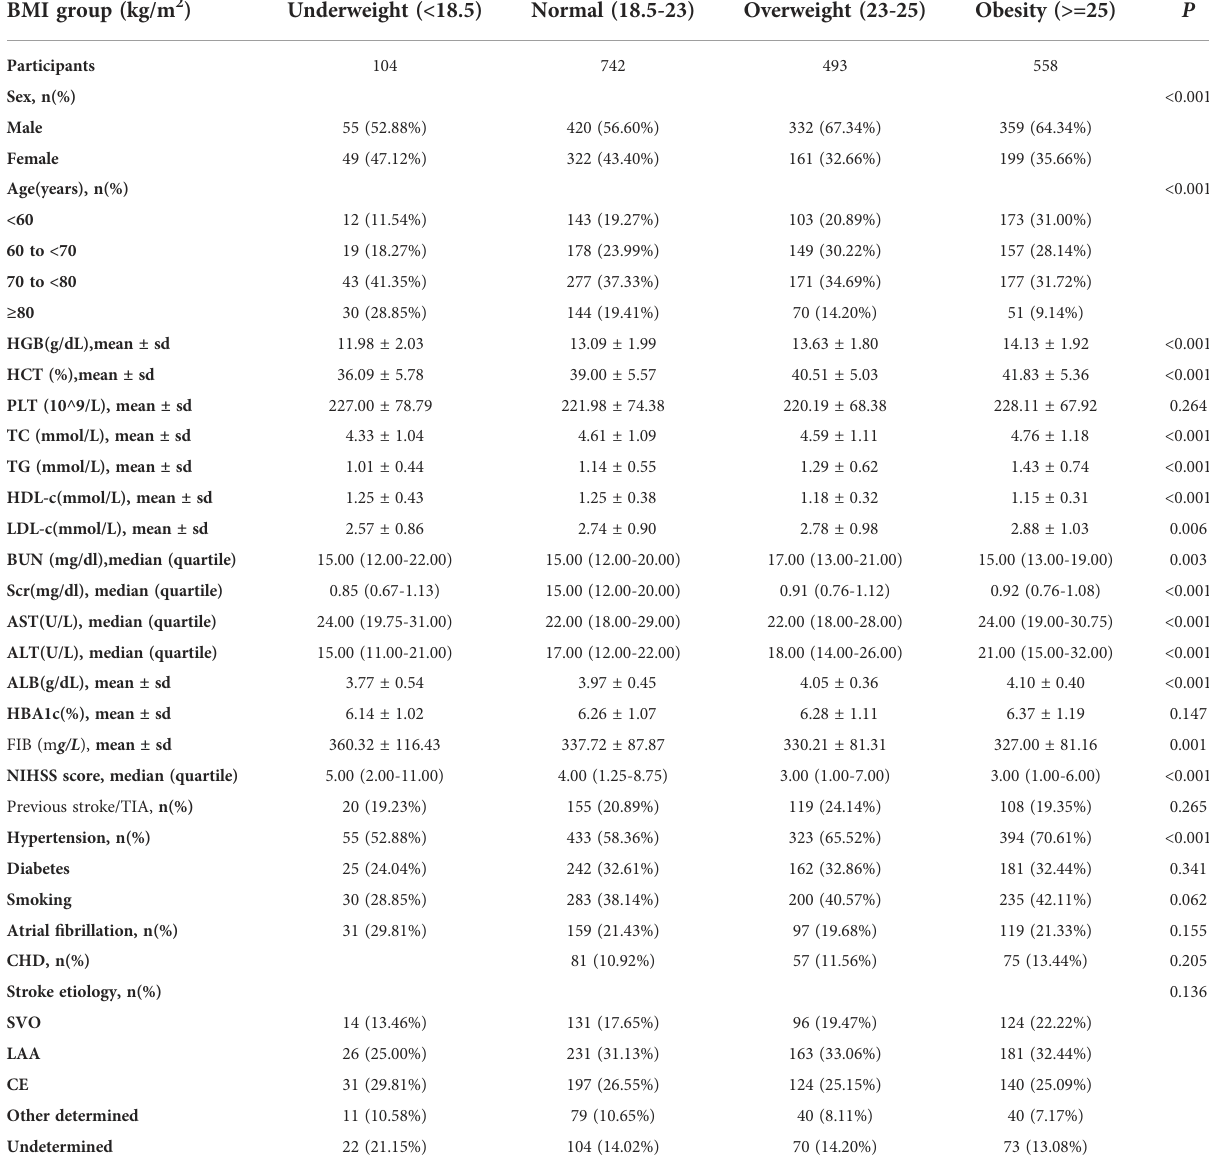
TABLE 1 The baseline characteristics of